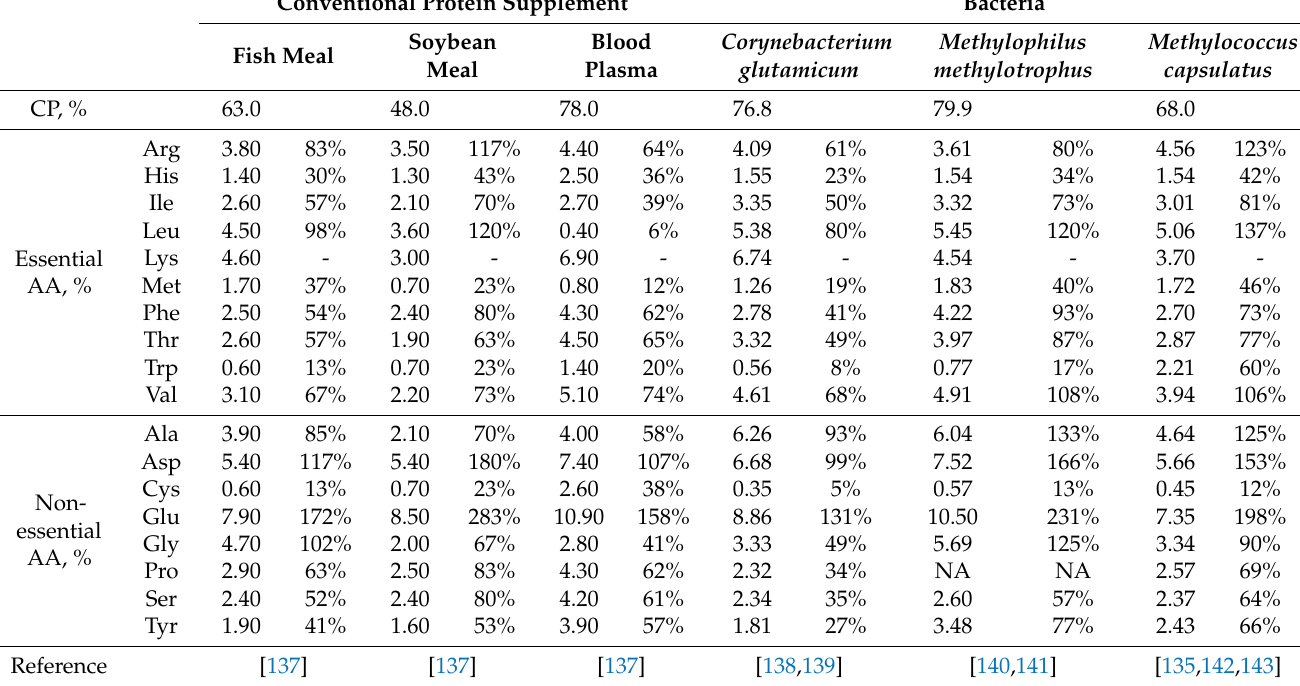
Table 4. Composition of crude protein (CP) and amino acids (AA-to-lysine ratio) of conventional protein supplements and bacterial protein